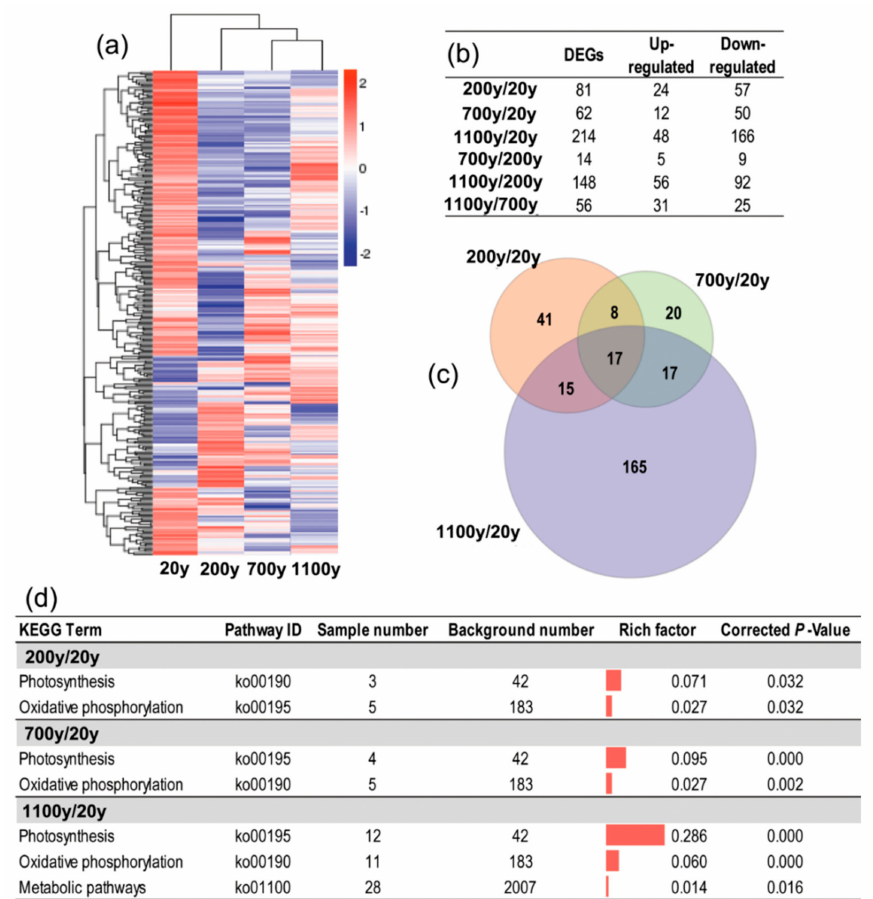
Figure 6. Analysis of di ff erentially expressed genes (DEGs) among the four analyzed Platycladus orientalis ages. ( a ) The heatmap of DEGs in pairwise comparisons; ( b ) Number of DEGs in pairwise comparisons; ( c ) A Venn diagram of the number of unique and common DEGs between di ff erent stages; ( d ) Significantly enriched KEGG pathways (corrected p -value < 0.05) in three comparisons (200- / 20-year-old, 700- / 20-year-old, and 1100- /